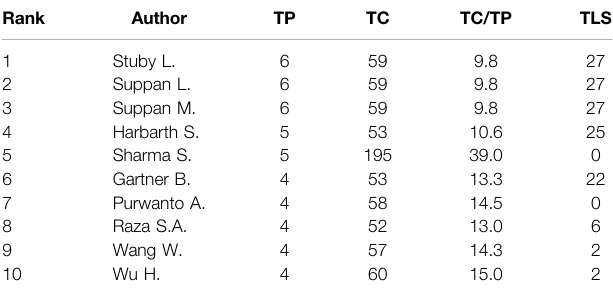
TABLE 3 | Top 10 most cited